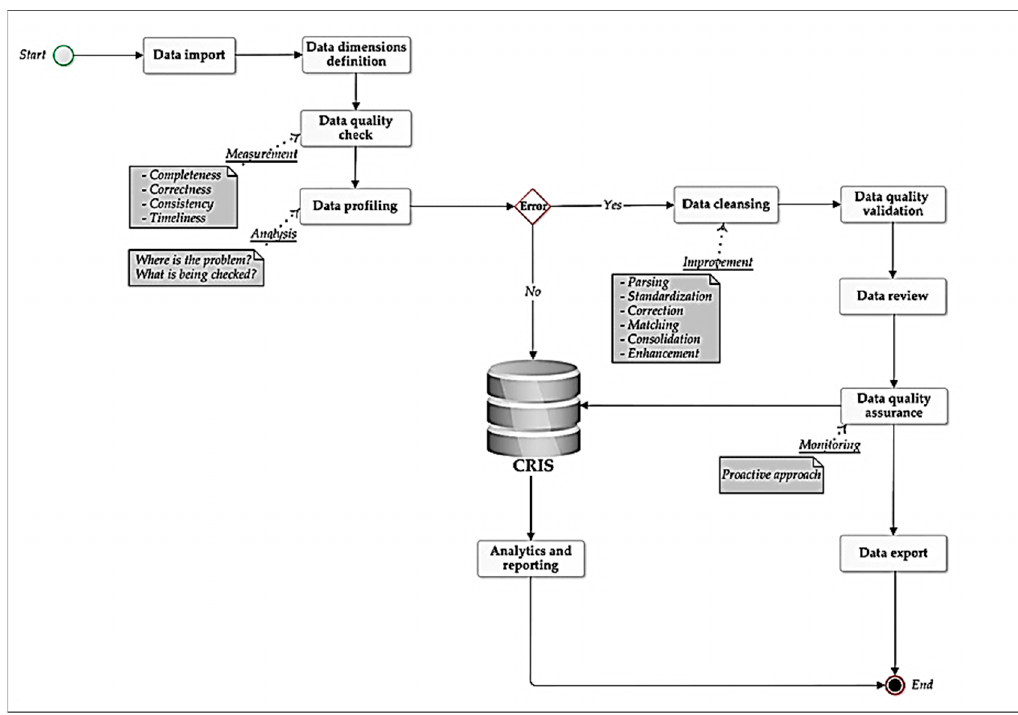
Figure 13. Iterative process flow for improving and monitoring the quality of CRIS data.